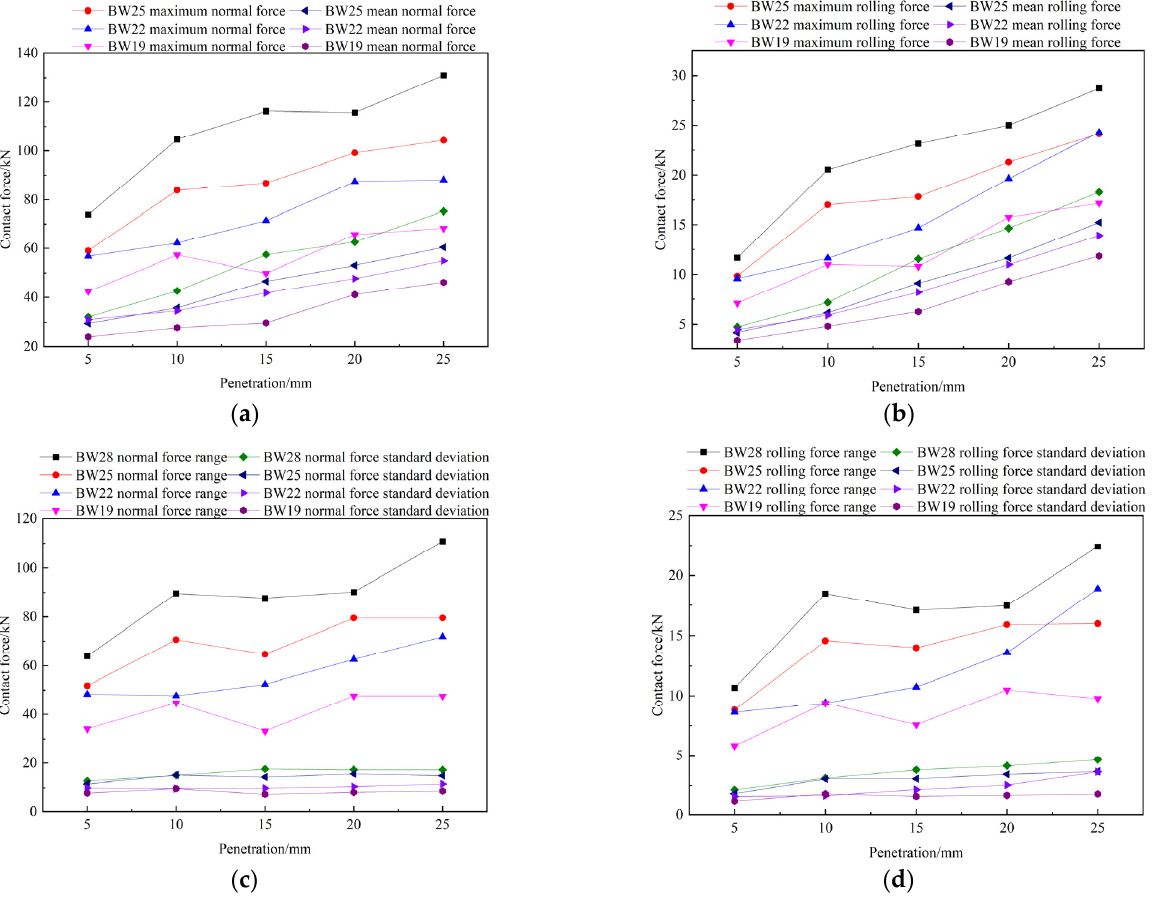
( d ) Figure 20. Equivalent stress isosurface of rock breaking using disc cutter with 5 mm blade fillet. ( a ) Isosurface of equivalent stress (Blade width 19 mm); ( b ) Isosurface of equivalent stress (Blade width 22 mm); ( c ) Isosurface of equivalent stress (Blade width 25 mm); ( d ) Isosurface of equivalent stress (Blade width 28 mm).